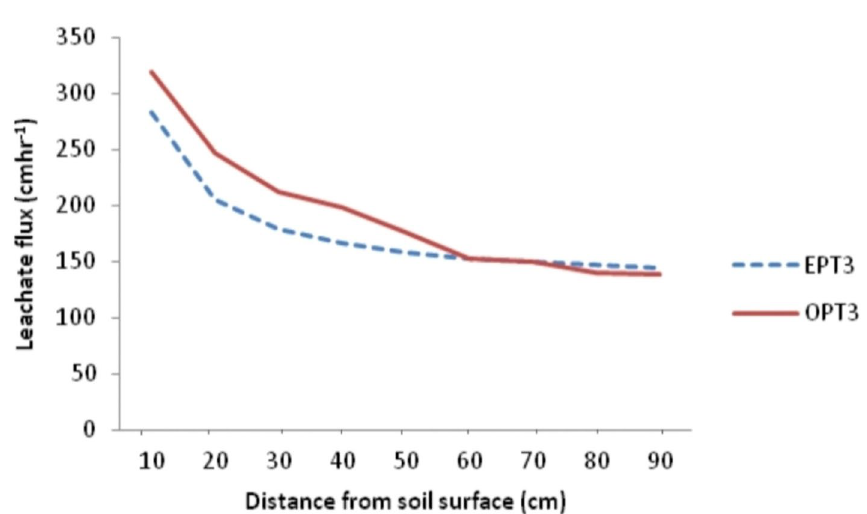
Figure 8. Pattern of observed and estimated leachate flux at PT03 in the dumpsite